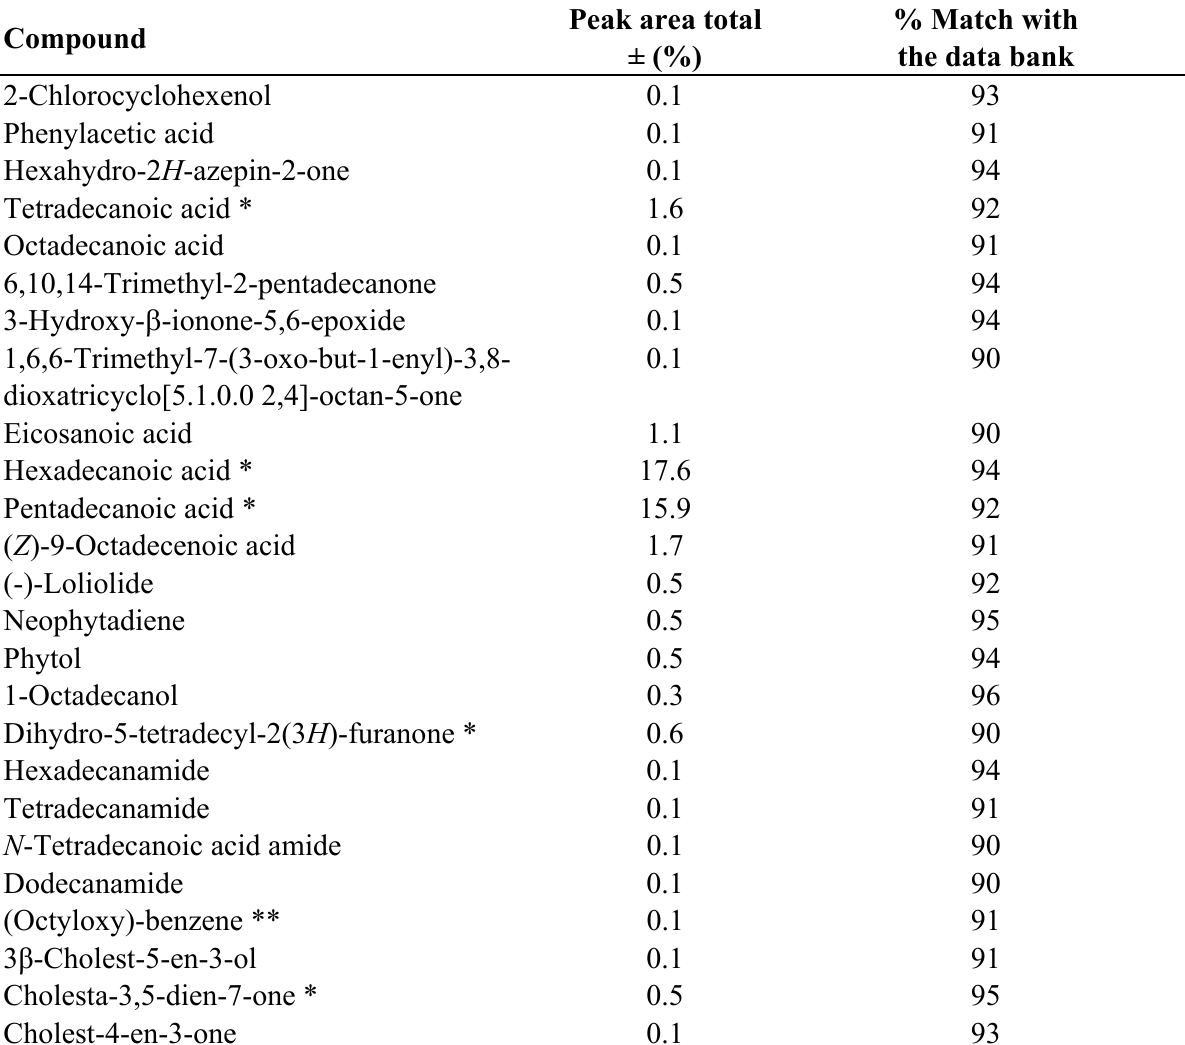
Table 1. Identification of compounds from hexanes and dichloromethane fractions from Centroceras clavulatum (Ceramiales, Rhodophyta).